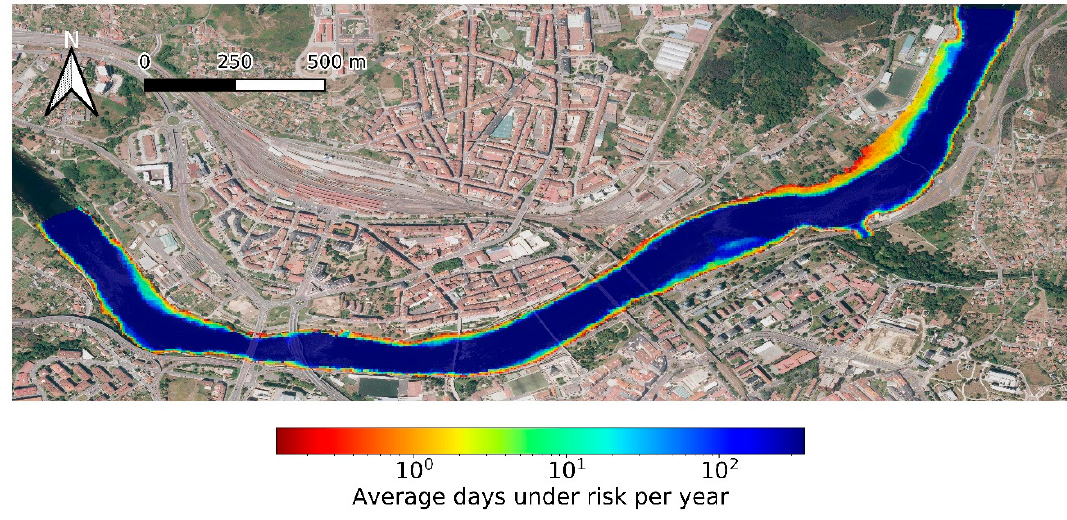
Figure 8. Average days under risk per year.